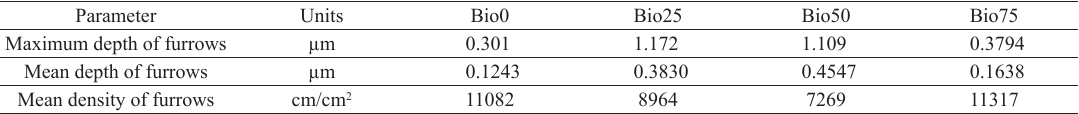
Table 2. The parameters of furrows of the samples.